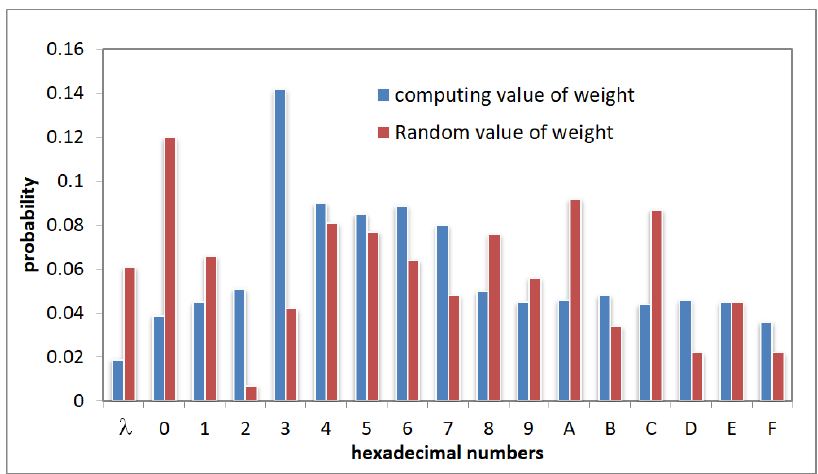
Figure 6. The distribution results of weight under different backgrounds.